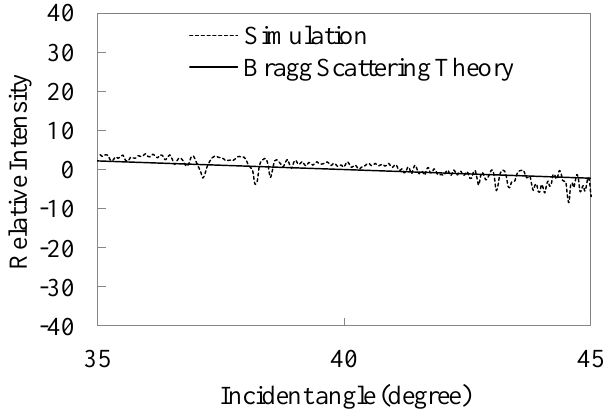
Figure 18. Average value of simulated SAR intensity without antenna beam pattern versus Bragg scattering theory (wind speed 5